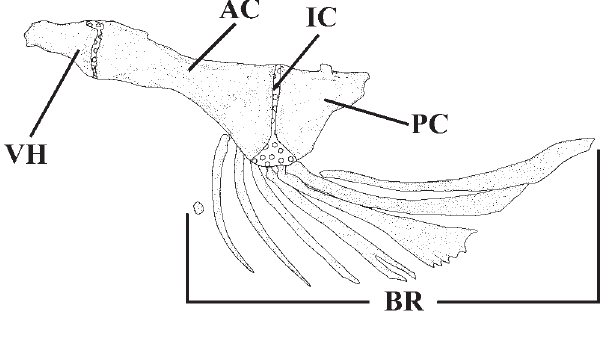
Fig. 7. Left hyoid arch of Trichomycterus maracaya (LIRP 4381), 43.9 mm SL, paratype. Lateral view. Abbreviations: AC , anterior ceratohyal; BR , branchiostegal rays; IC , inter- ceratohyal cartilage; PC , posterior ceratohyal; VH , ventral hypohyal. Scale bar = 1.5